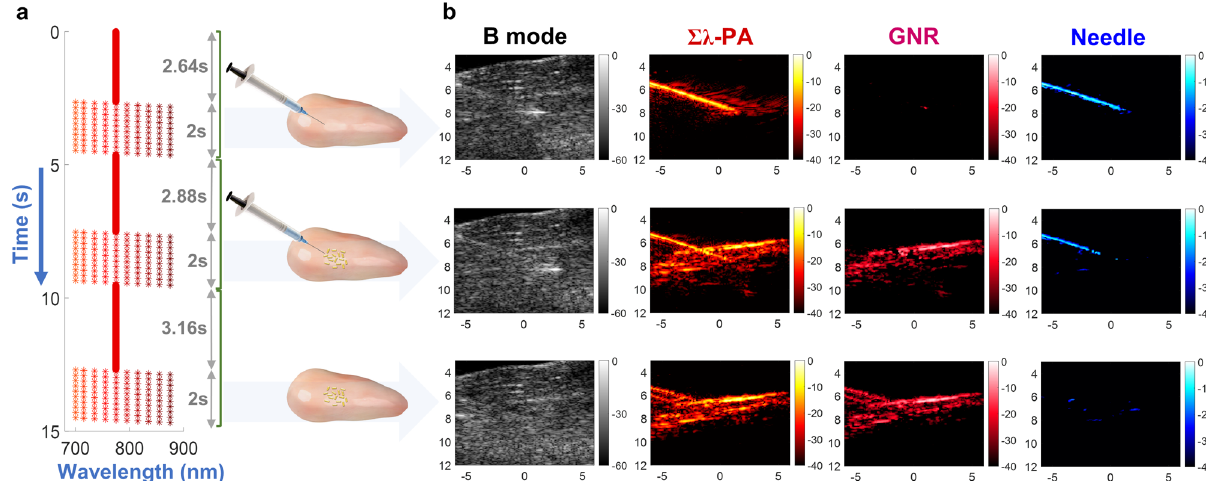
Fig. 4 Ex vivo spectroscopic PA imaging for needle guidance with nanoparticle injection into chicken breast. a Laser sequence and timing diagram for the following three operations: needle insertion into the chicken breast, GNR injection, and needle pullout. For each operation, the laser pulse sequence was designed to scan with a fi xed wavelength of 775 nm, followed by 10 cycles sweeping over 10 wavelengths. b PAUS imaging results including needle insertion into chicken breast (top row), GNR injection (center row), and needle pullout (bottom row). Four simultaneous but different imaging modalities are compared, including: B-mode (left column), wavelength-compounded Σλ -PA (second column), GNR-weighted PA (third column), and needle-weighted PA (fourth column). GNR and needle-weighted PA images are produced by the product of Σλ -PA and measured spectra correlated with individual reference spectra. The reference spectrum of GNR was measured by UV – VIS whereas that of the needle was determined by PA measurements in de- ionized water (Supplementary Note 5). The horizontal and vertical axes represent lateral and axial dimensions in units of mm,